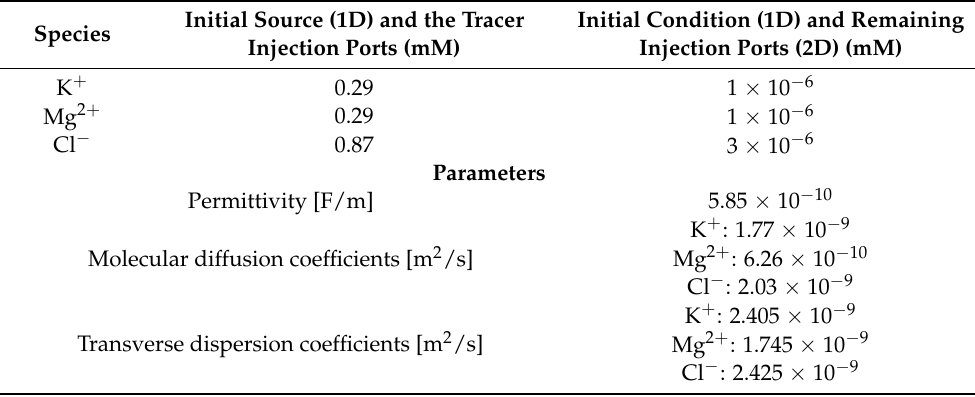
Table A3. Boundary and initial conditions, chemical system, and parameters for benchmark